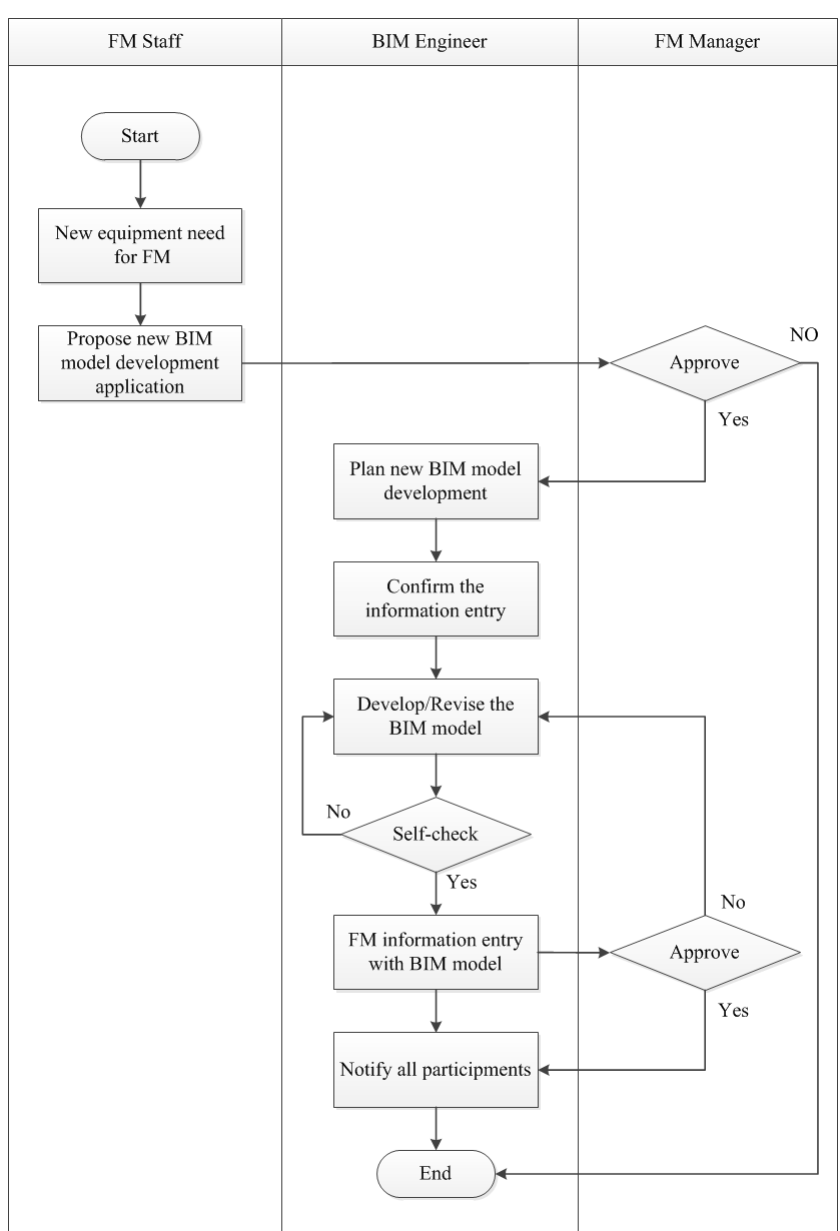
Figure 7. The use of new BIM models inspection process in the case study.